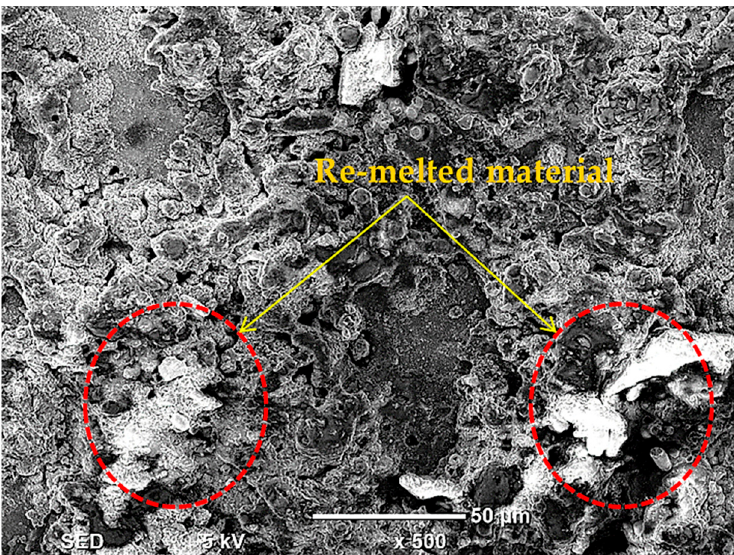
Figure 18. SEM micrograph showing evidence of reposition layers on the workpiece surface. Table 5. Desired settings for R DE and A DE